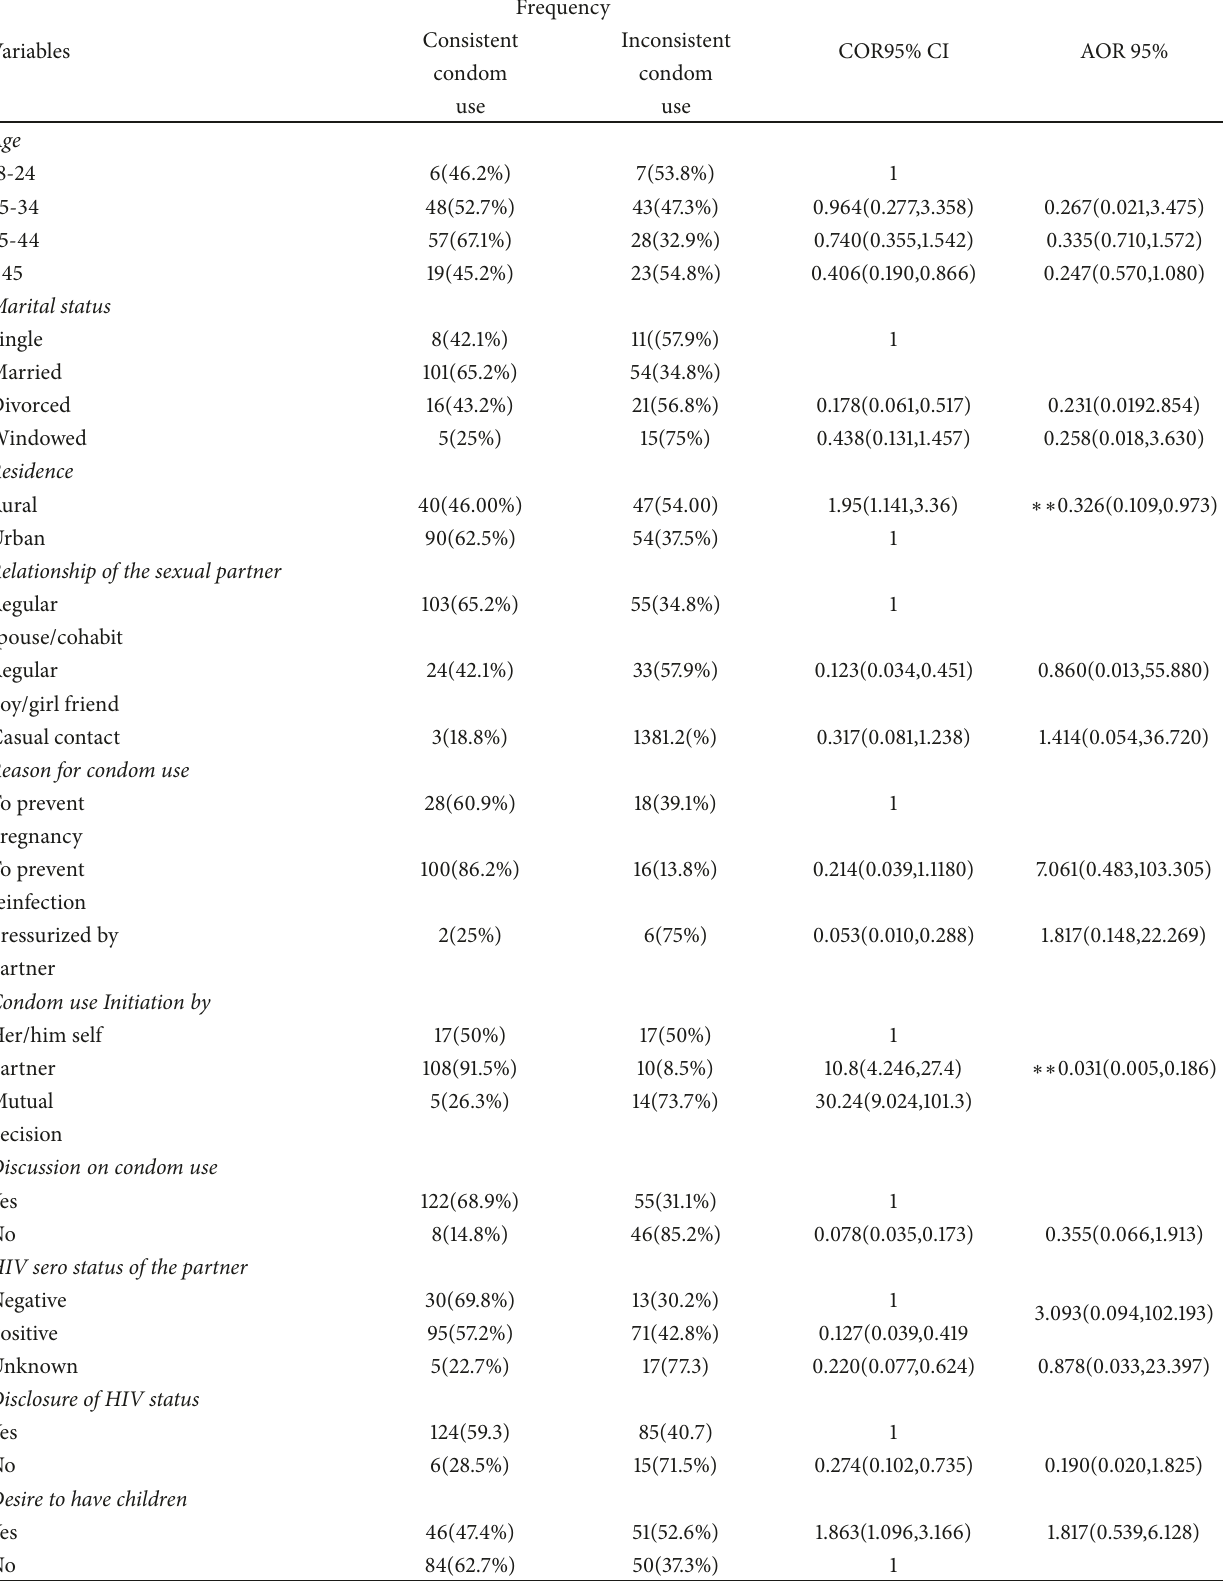
Table 6: Multivariate analysis of predictors of consistent condom use in HIV infected persons, condom use survey, Kolladiaba health center, mNorth West Ethiopia,